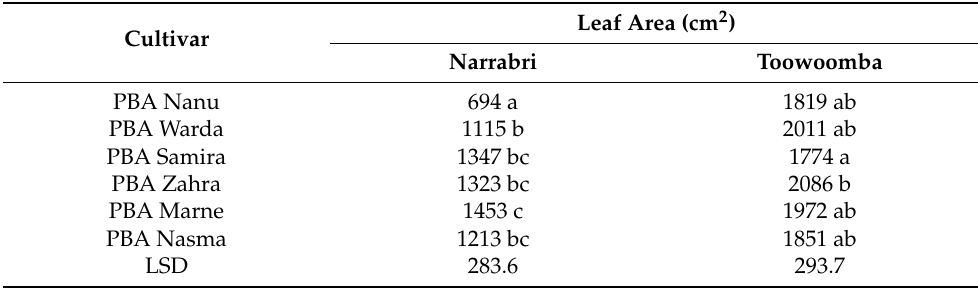
Table 6. Leaf area (cm 2 ) of different faba bean cultivars grown in Narrabri and Toowoomba. Means with a different letter are significantly different at p -value ( α = 0.05).